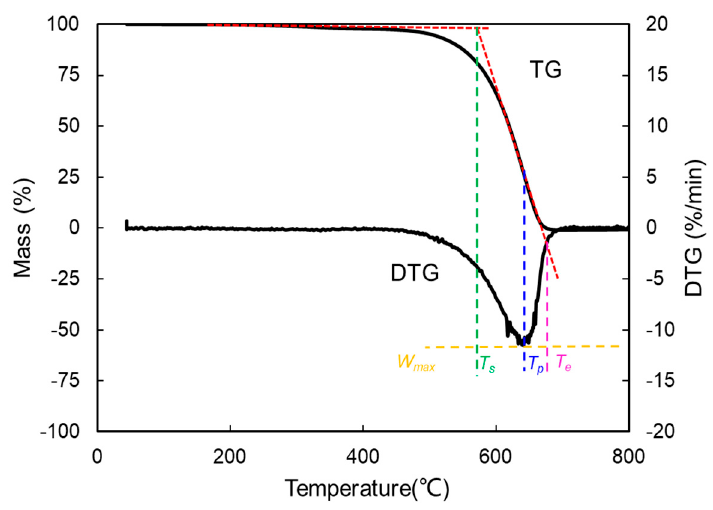
Figure 3. Definition of characteristic parameters in TG-DTG curves of soot oxidation.